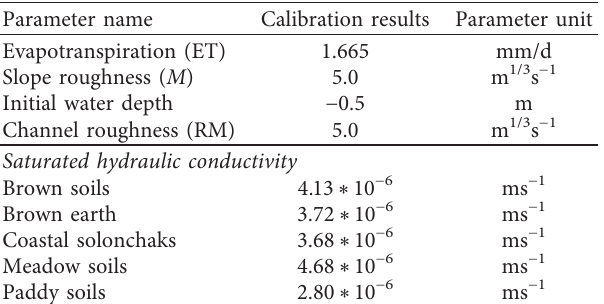
Table 4: Parameter rate determination result.